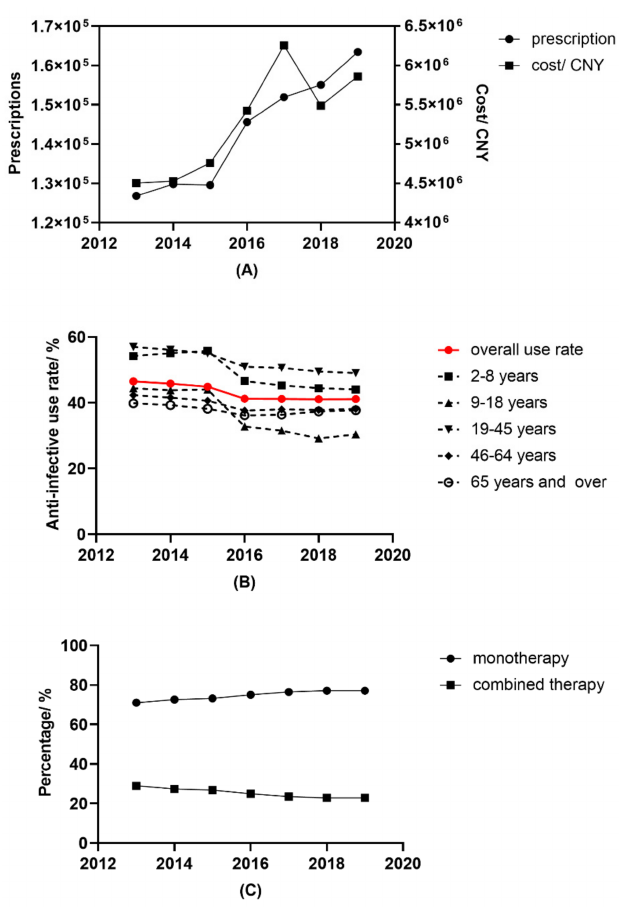
Figure 1. Trends in ocular topical anti-infective use in 61 sampling hospitals from 2013 and 2019. ( A ) Yearly prescriptions and cost; ( B ) overall use rate and age stratified use rate of ocular topical anti-infectives; ( C ) prescription